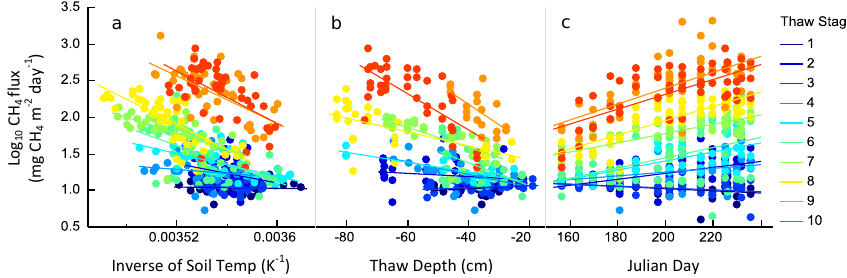
Figure 4. (a) Arrhenius plots for each thaw stage. (b) Linear fit between thaw depth and CH 4 flux with progressing thaw. (c) Increase in seasonality of CH 4 flux as the permafrost thaws.